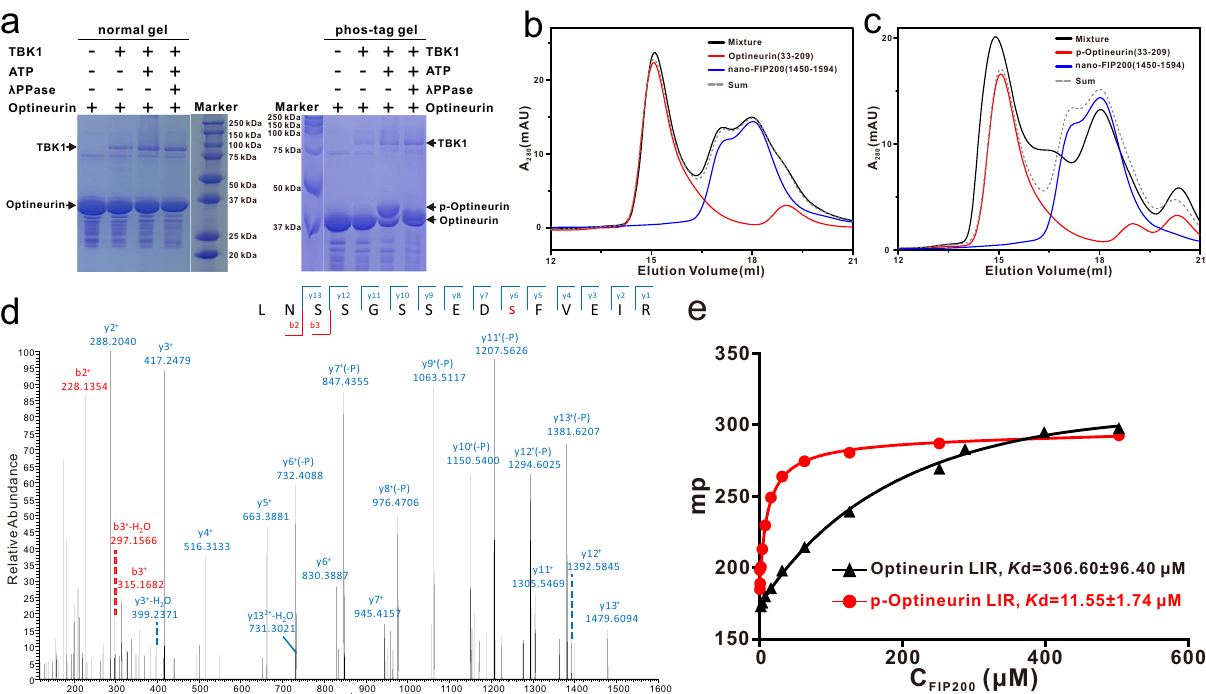
Fig. 3 TBK1-mediated phosphorylation of the LIR region of Optineurin can promote the interaction between Optineurin and FIP200 Claw. a In vitro phosphorylation assays showing that Optineurin(33 – 209) could be speci fi cally phosphorylated by the puri fi ed TBK1 kinase. The gel in the left panel is normal SDS-PAGE gel, while the right one is a phos-tag gel. In this panel, p-Optineurin stands for phosphorylated Optineurin(33 – 209). This experiment was repeated twice independently with similar results. Source data are provided as a Source Data fi le. b Analytic gel fi ltration chromatography-based analysis of the interaction of FIP200 Claw domain with Optineurin(33 – 209). In this panel, “ Sum ” stands for the theoretical sum of Optineurin(33 – 209) and nano-FIP200(1450 – 1594) pro fi les, while “ Mixture ” stands for the Optineurin(33 – 209) and nano-FIP200(1450 – 1594) mixture sample. Source data are provided as a Source Data fi le. c Analytic gel fi ltration chromatography-based analysis of the interaction of FIP200 Claw domain with the phosphorylated Optineurin(33 – 209) mediated by TBK1, which is named as p-Optineurin(33 – 209). Source data are provided as a Source Data fi le. d The fi gure shows a higher-energy collisional dissociation (HCD) MS/MS spectrum recorded on the [M + 2H] 2 + ion at m / z 853.87 of the human Optineurin peptide LNSSGSSEDsFVEIR harboring one phosphorylated site (denoted by lowercase s). Predicted b- and y-type ions (not including all) are listed above and below the peptide sequence, respectively. Ions observed are labeled in the spectrum and indicate that the S177 residue of Optineurin(33 – 209) protein is modi fi ed with the phosphate. e Fluorescence polarization assays measure the binding af fi nities of FIP200 Claw domain (residues 1490 – 1594) with Optineurin LIR (residues 169 – 185) (black) and the phosphorylated Optineurin LIR (p-Optineurin LIR) (red). K d values are the fi tted dissociation constants with standard errors when using the one-site binding model to fi t the FP data. Source data are provided as a Source Data fi FAM134B (Fig. 1a), should also be recognized by FIP200 Claw.